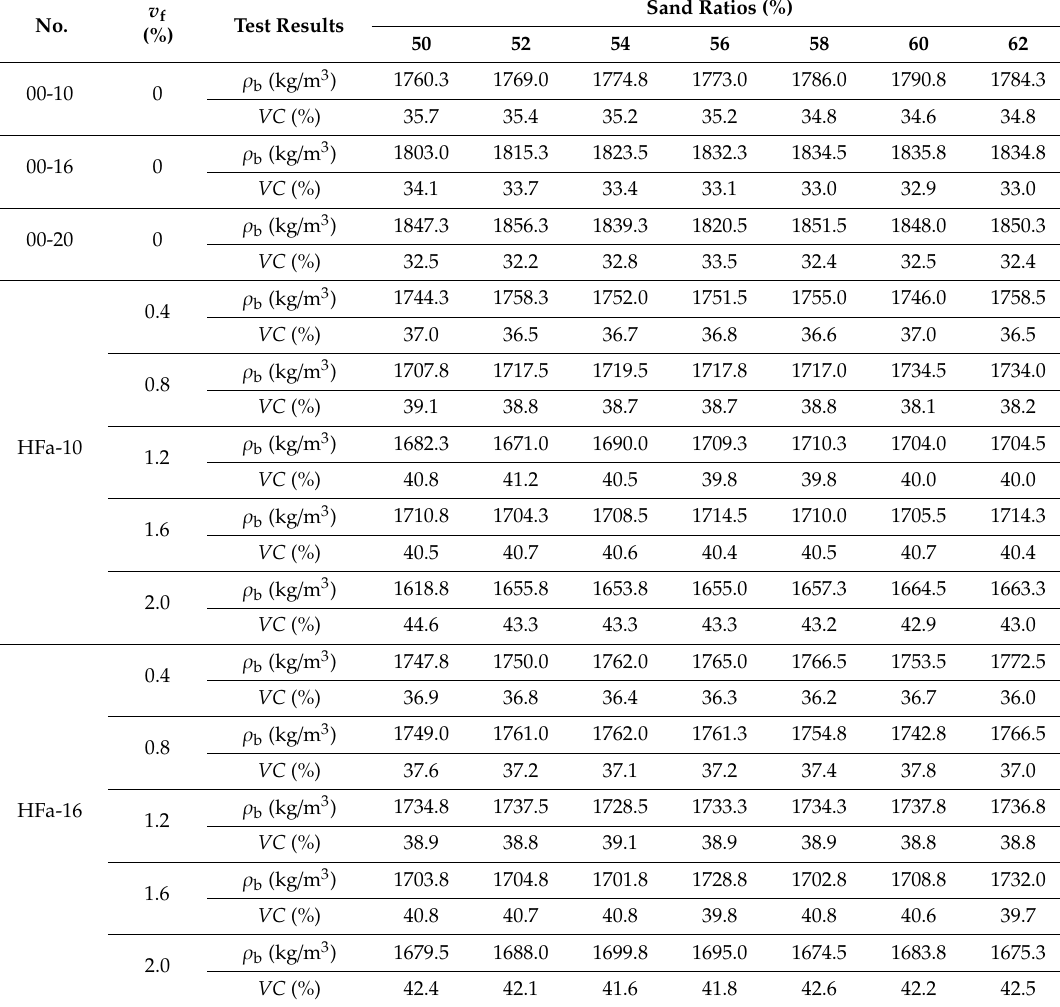
Table A1. The packing test results for steel fiber aggregate